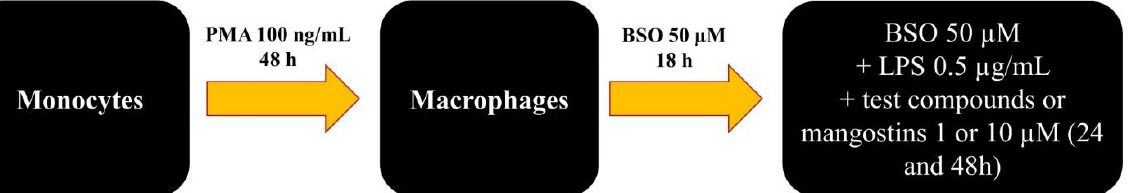
Scheme 2. In vitro experimental model used for the screening of xanthone derivatives 1 – 40 and controls (mangostins). Undifferentiated human monocytes (CRL-9855™) were stimulated with 100 ng/mL of PMA (phorbol-12-myristate-13-acetate) for 48 h to obtain differentiated macrophage-like